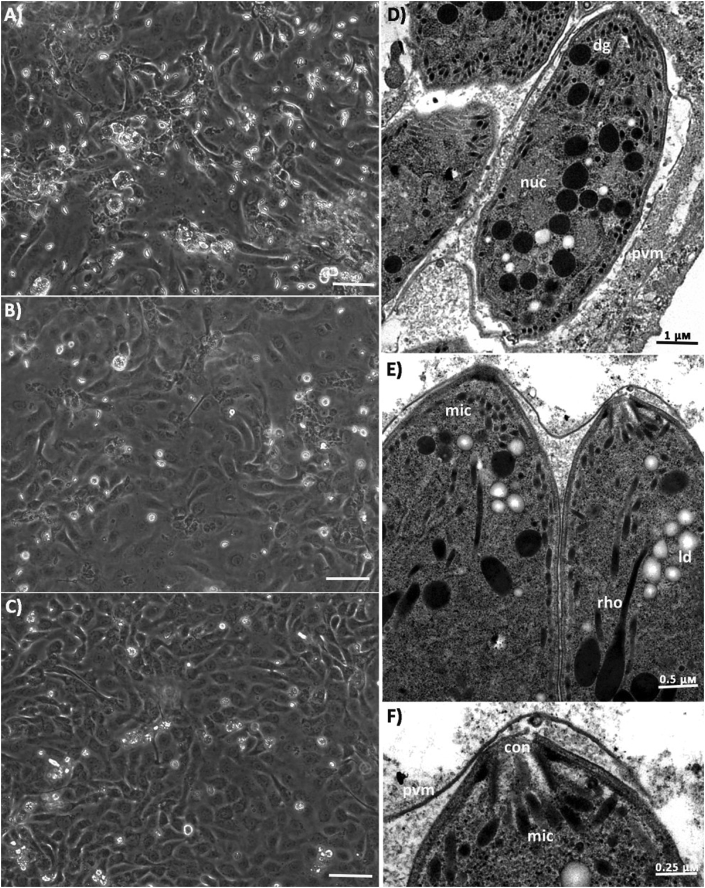
Light microscopy and TEM analysis of BKI 1369 untreated and treated C. suis infected IPEC-1 monolayers 5 dpi; Compared to control culture (A) significantly lower number of free merozoites counts were observed in cultures treated with IC50 (B) and IC95 (C) concentrations of BKI; Transmission electron micrograph of C. suis merozoites in untreated (D) and BKI treated (E & F) cultures; con: conoid; rho: rhoptries; mic: microneme; dg: dense granule; nuc: nucleus; ld: lipid droplet; pvm: parasitophorus vacuole membrane.